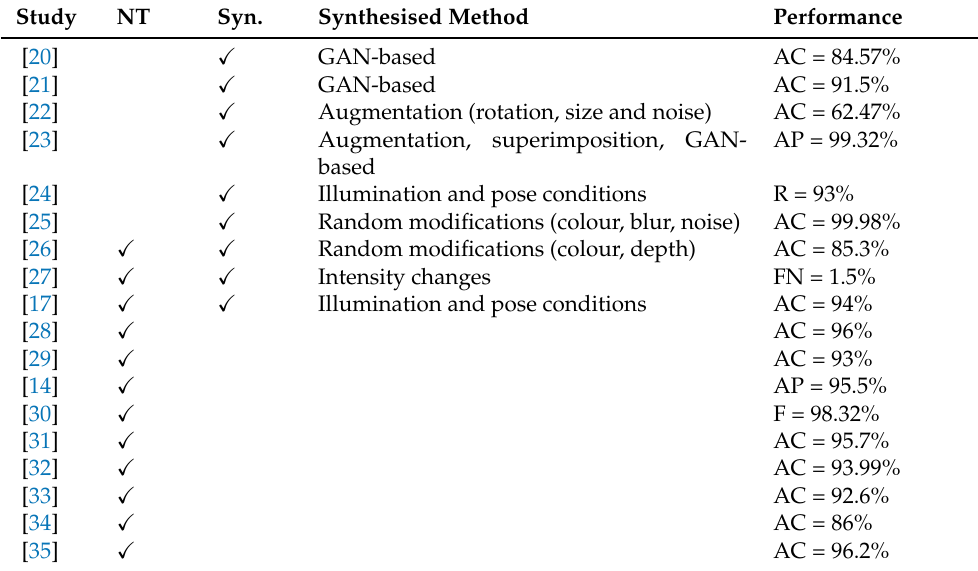
Table 2. Comparison of studies with synthetic and nighttime